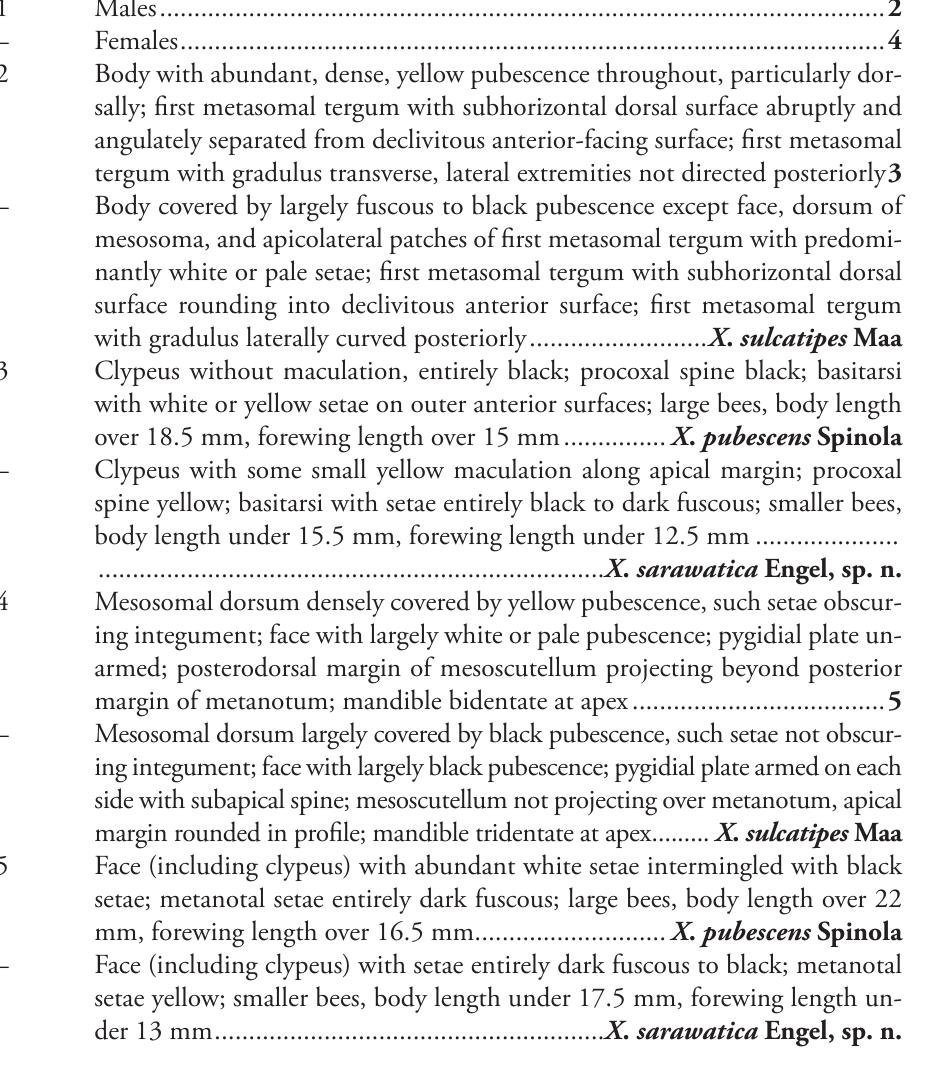
with gradulus laterally curved posteriorly .......................... X . sulcatipes Maa